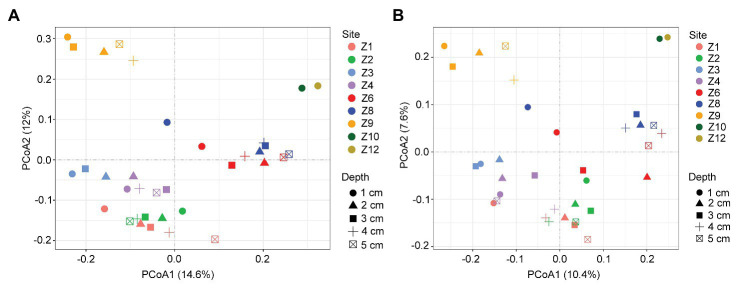
Plots of principal coordinates analysis (PCoA) of microbial eukaryotes based on Bray Curtis dissimilarities (A) and Unweighted UniFrac distance matrices (B).